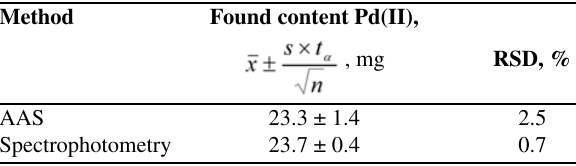
Table 5. Results of the determination of palladium(II) in the resi- stor, n = 3, P =